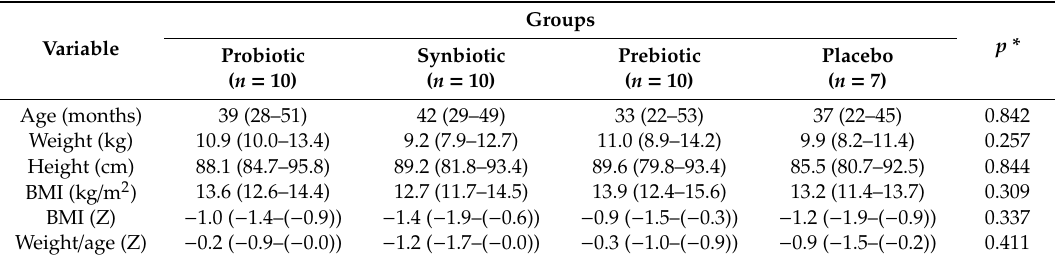
Table 1. Baseline characteristics of the study